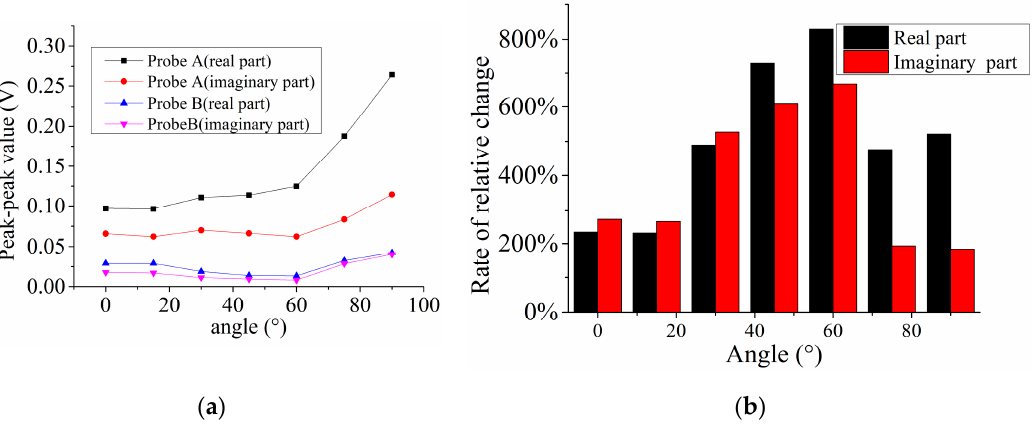
Figure 8. Peak contrast of the signals of two probes: ( a ) peak-to-peak value, ( b ) rate of change of peak-to-peak value.